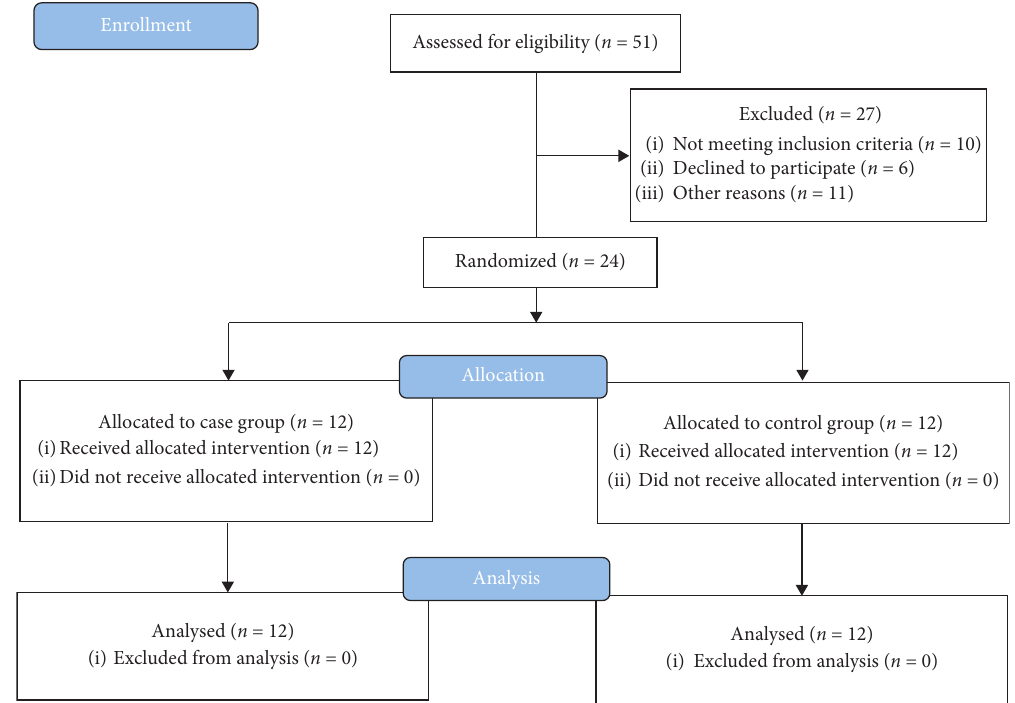
Figure 1: Study design